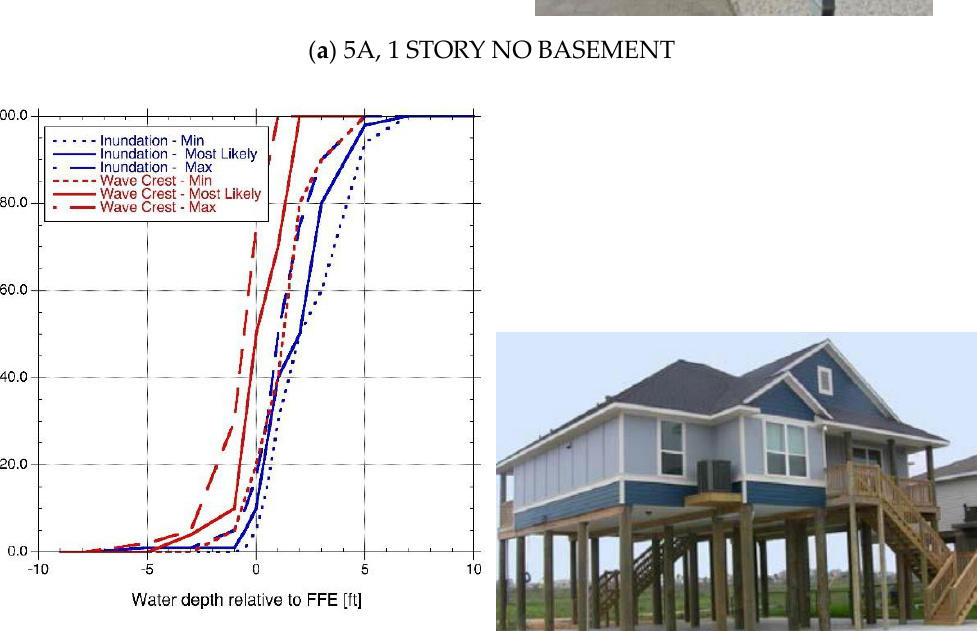
Figure 5. Damage (structural) functions (% damage vs water elevation (ft) above FFE) for inundation (blue) and waves (red) for ( a ) 5A (single story with no basement) and ( b ) 7A (open pile foundation) residential structures are shown. A photograph of each structure type is provided. Damage functions for minimum, most likely, and maximum values are provided.